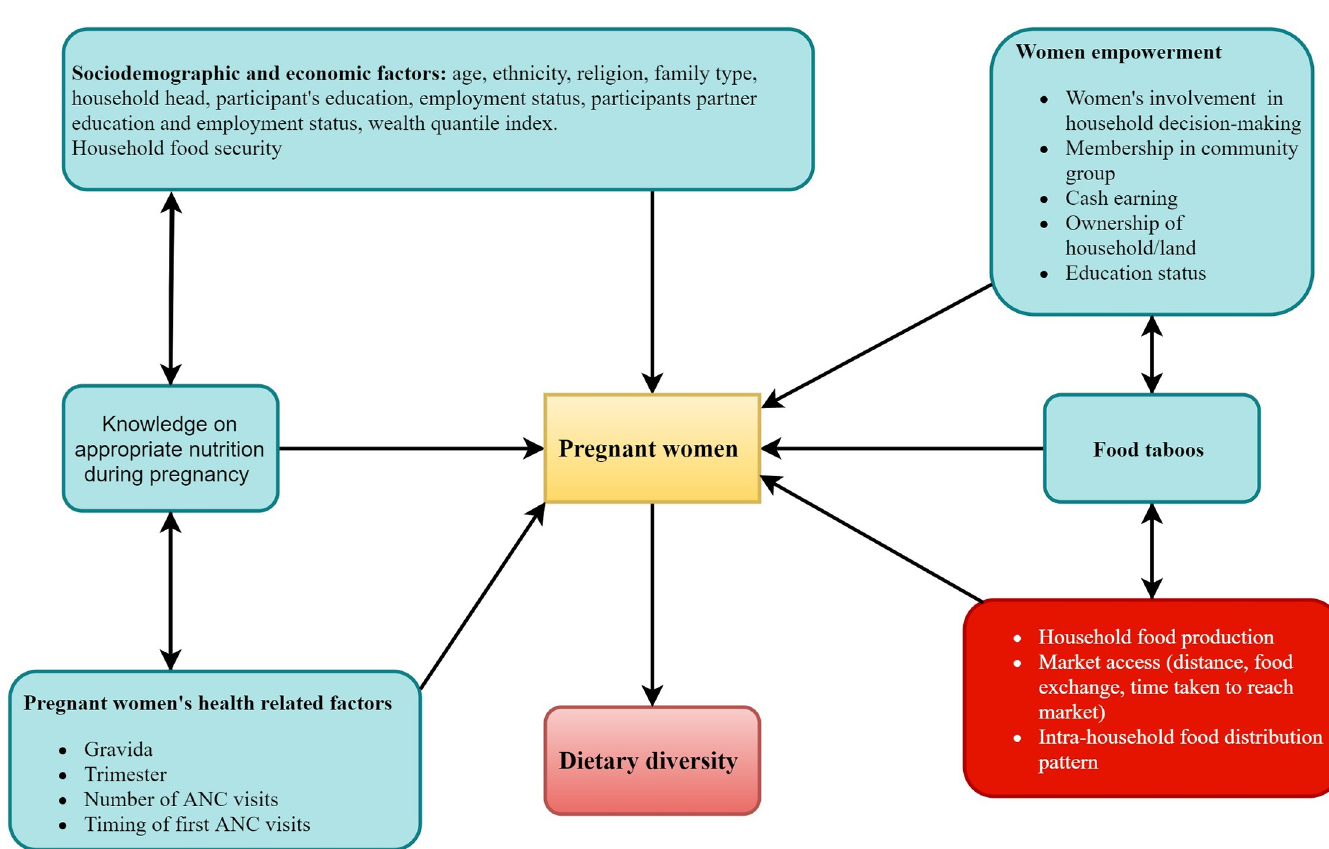
Fig 2. Conceptual framework on factors associated with dietary